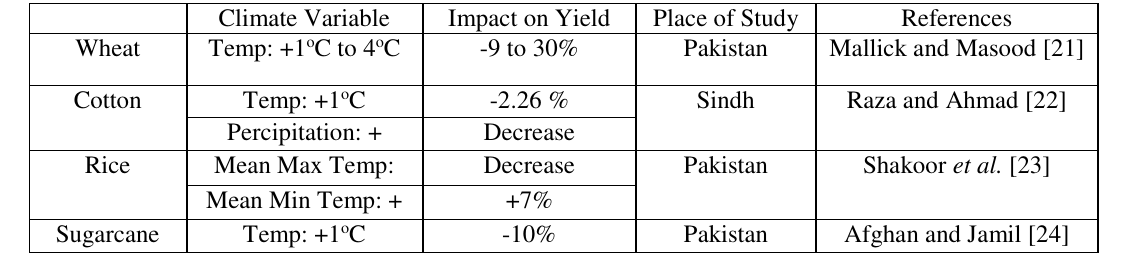
Table 4: Impact on